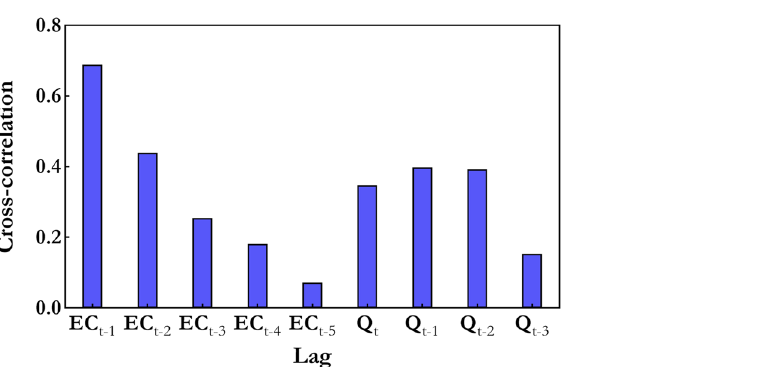
Figure 6. Cross correlation between input and target